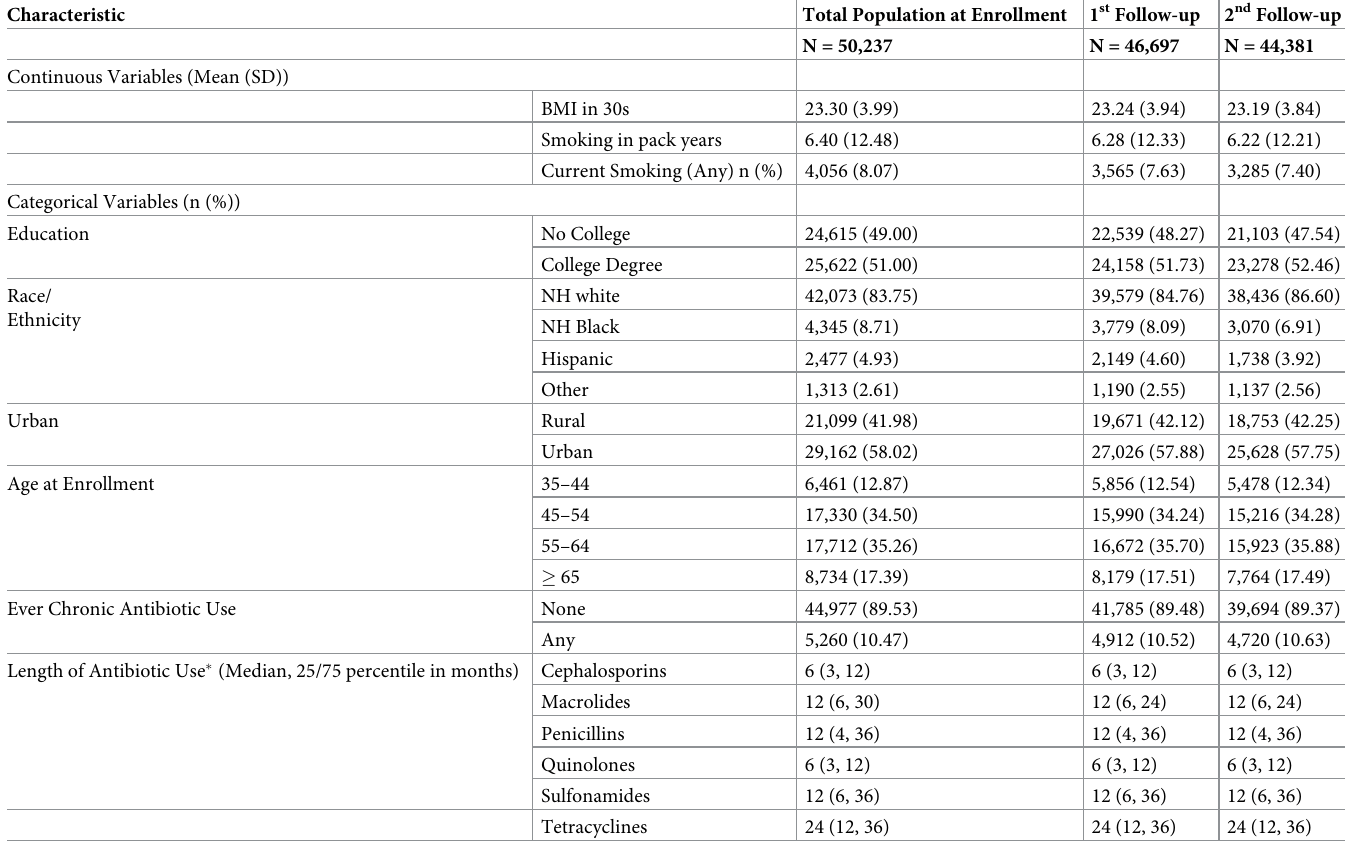
Table 1. Characteristics of study population by